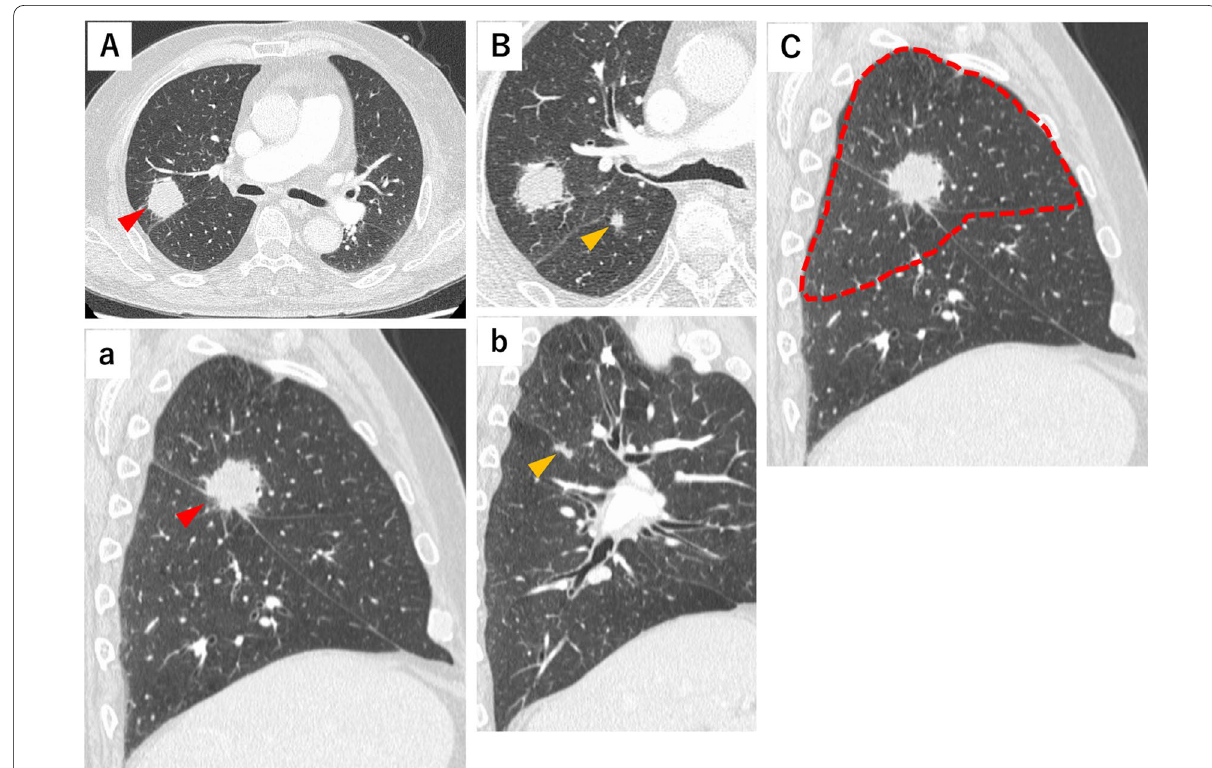
Fig. 1 A Right upper lobe lung cancer (adenocarcinoma, pT2a (32 mm), N0M0, Stage IB). (a) Tumor is located near the trilobar confluence. Good lobulation of the middle and lower lobes. B (b) Right lower lobe lung cancer (squamous cell carcinoma, pT1a (7 mm), N0M0, Stage IA1). C Extent of